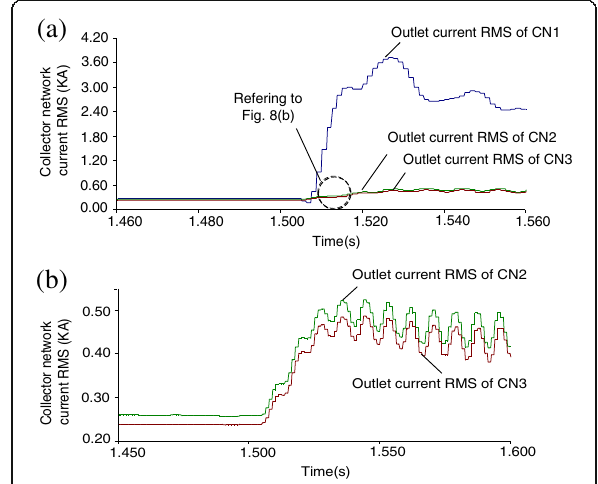
Fig. 8 a Collecting power lines current RMS waveforms for k2 fault and b partial enlarged view